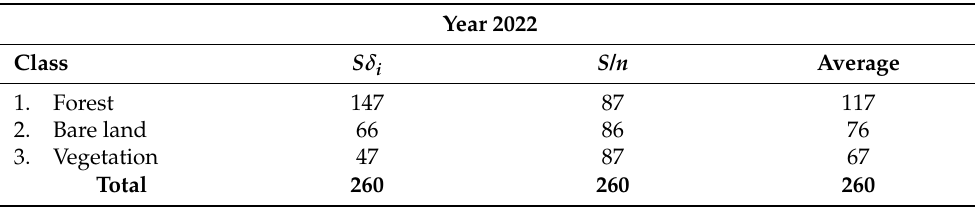
Table 7. Samples stratification for the classified data of the year